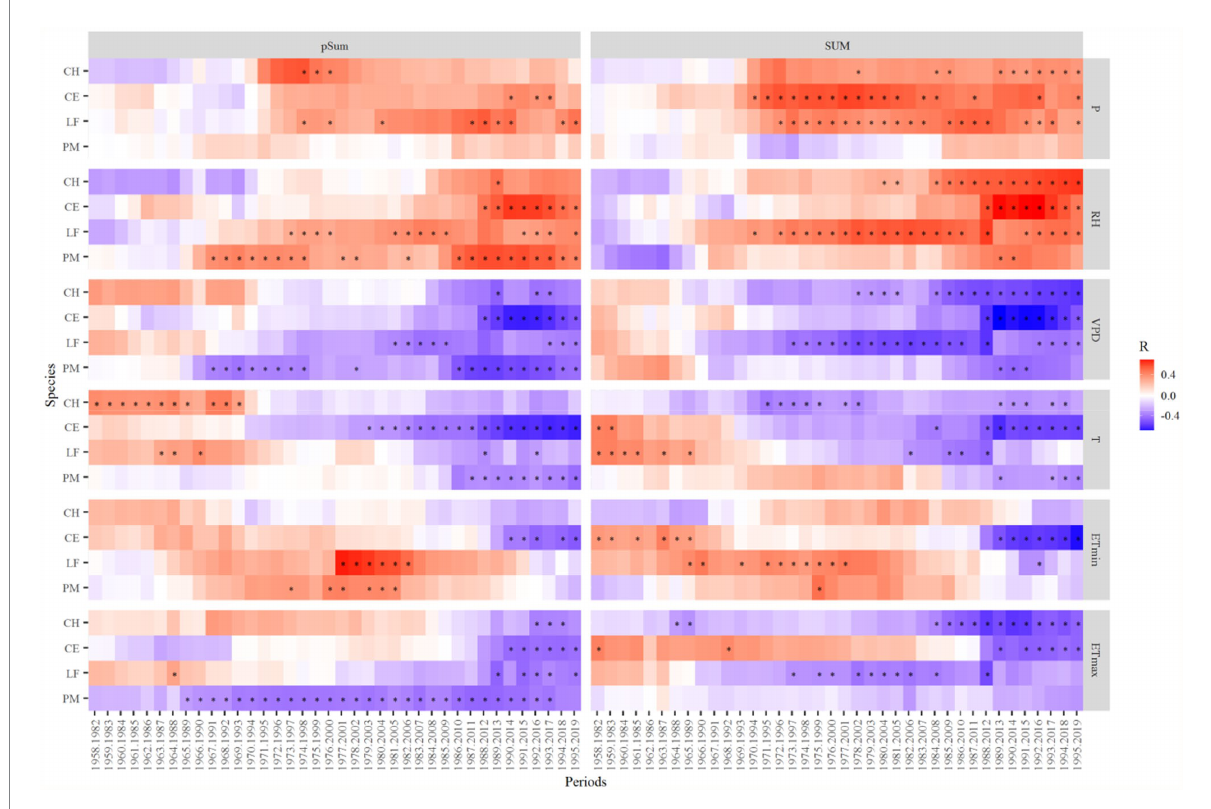
FIGURE 8 Moving correlation analysis of the standard tree-ring chronologies during 1958–2019. Correlation coefficients were computed for 25-year moving windows. The vertical bars on the right side of the graph represent the scale of correlation coefficients. pSum, previous year June to August, SUM, current year June to August. * p <